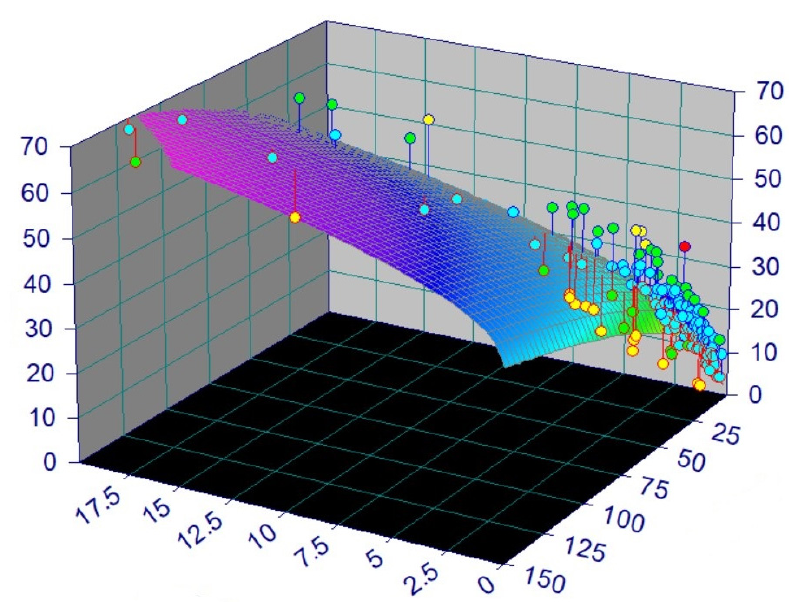
Figure 19. When the Froude number is substituted into the calculation formula, the correlation between the calculated value and the experimental value is as shown ( xyz axis represents v sg , Froude number and pressure drop (kPa), respectively).